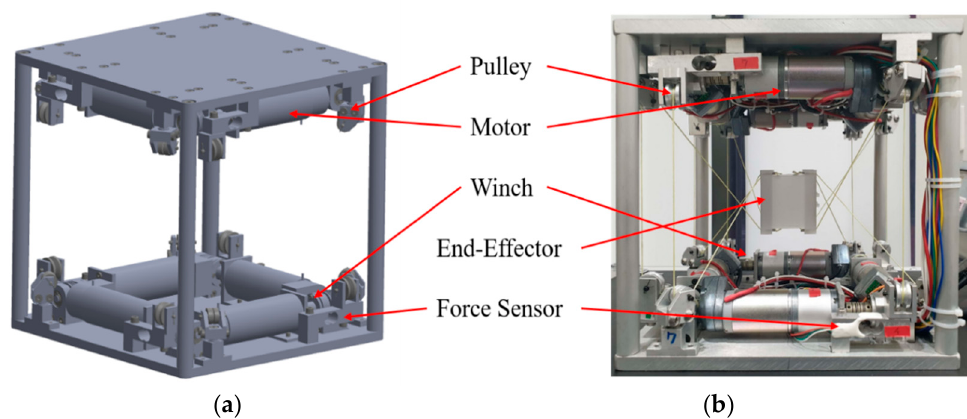
Figure 2. Designed and fabricated models of the main part of the system: ( a ) designed model of the main system; ( b ) fabricated model of the main system.